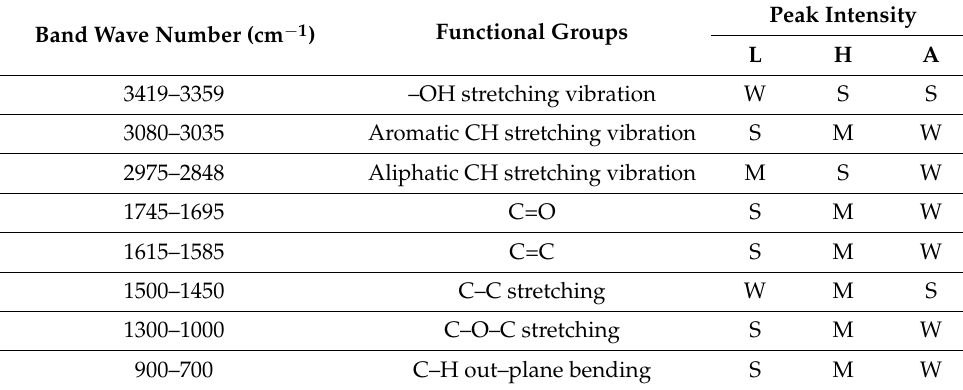
Table 5. Band assignments of bituminous coal derived from FTIR Spectra [260]. Peak Intensity Band Wave Number (cm − 1 ) Functional Groups L H A –OH stretching vibration W S S Aromatic CH stretching vibration S M W Aliphatic CH stretching